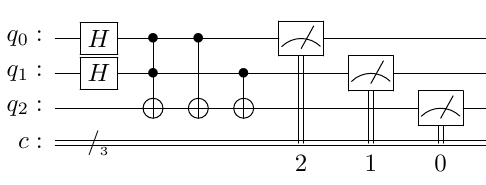
Figure 6. Quantum circuit for the OR operation.